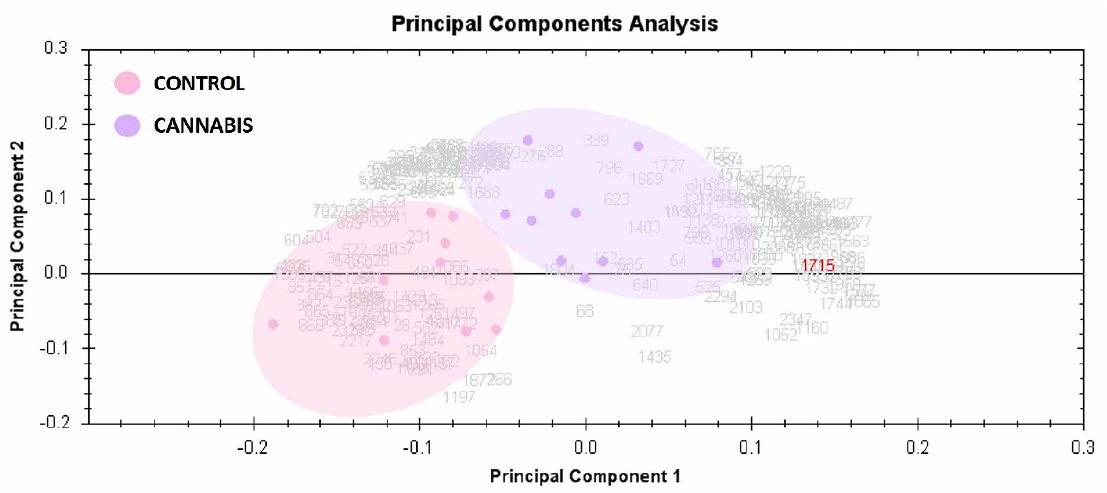
Figure 4. Principal component analysis of the proteomic dataset. Principal component analysis is presented in the figure where purple dots are the plasma samples from cannabis group and pink dots are from control group. Together, these explained 64% of the selected spot’s variability values. Colored dots and numbers are represented of the gels and spots, respectively.